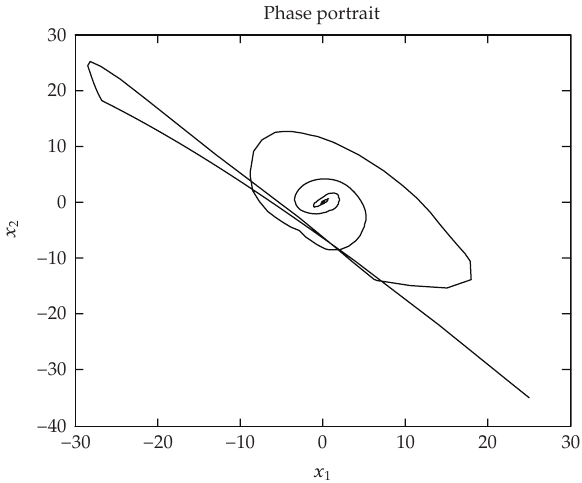
Figure 5: Phase portrait of the evolution of the